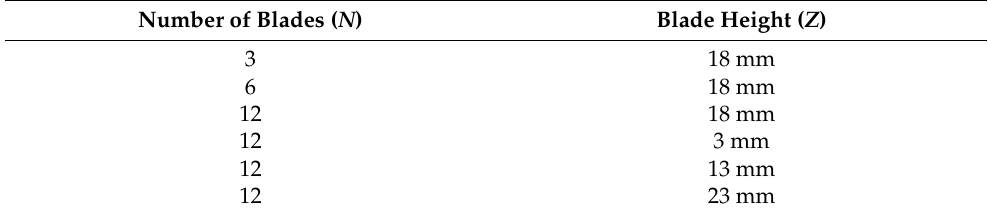
Table 2. Ventilation fans